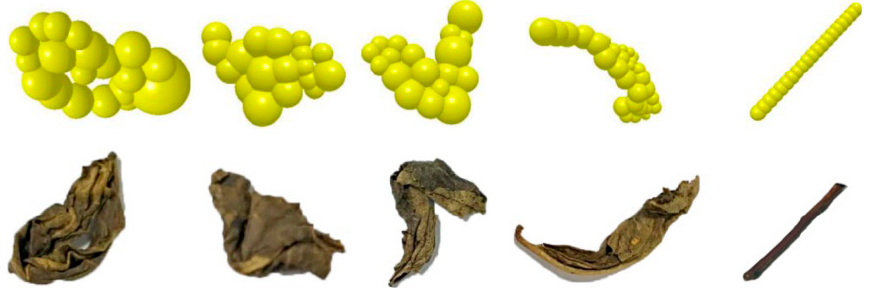
Figure 3. Simulation models for various shapes of tea materials.